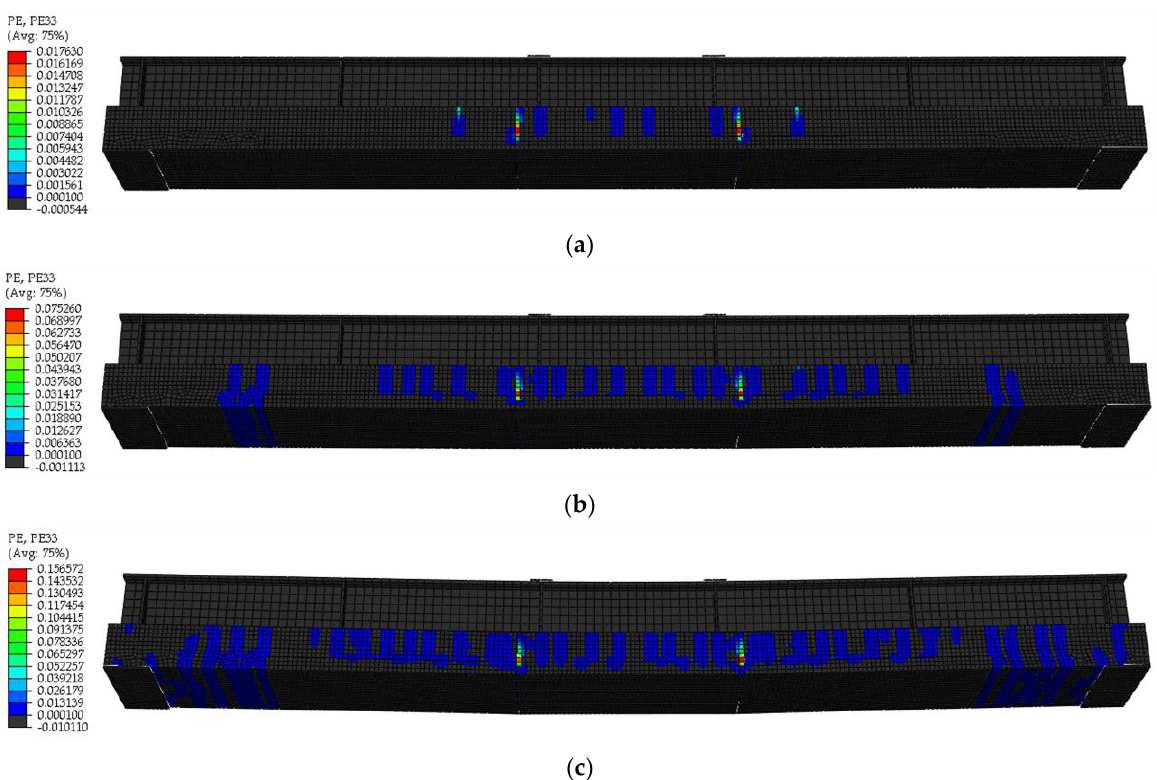
Figure 10. Crack development for a UHPC layer ratio of 0.3: ( a ) applied load equals 120 kN; ( b ) applied load equals 310 kN; ( c ) applied load equals 345